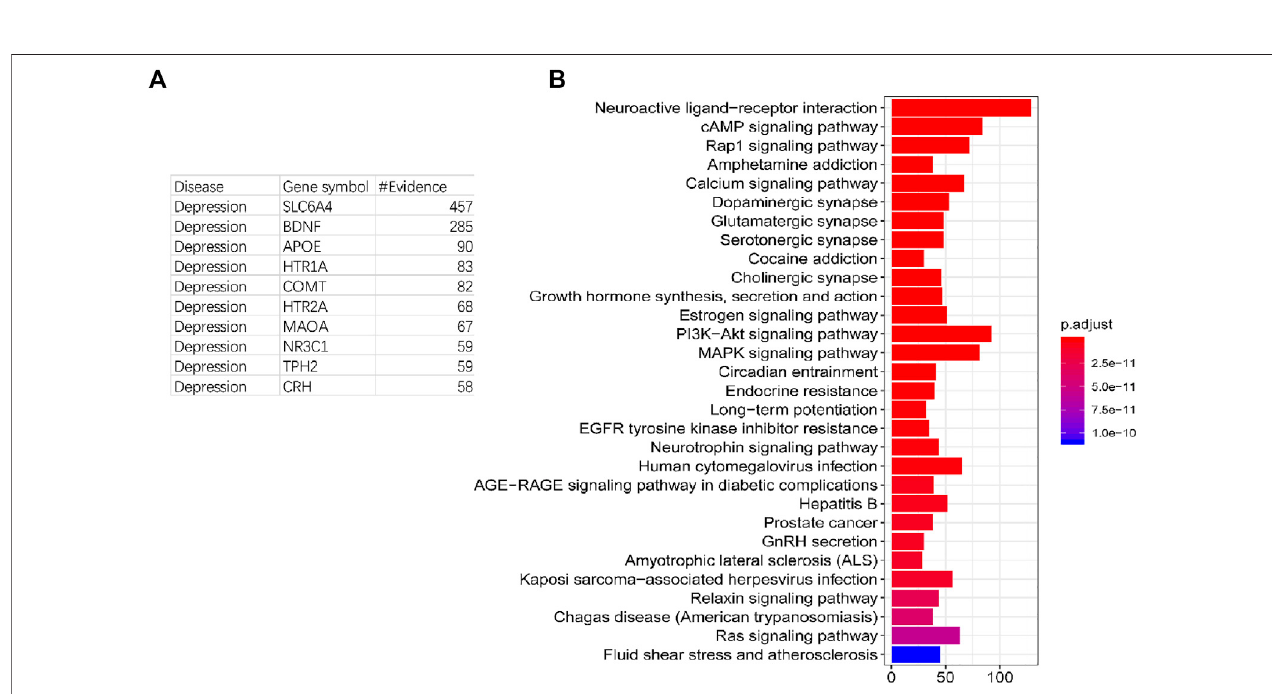
FIGURE2| Numberofevidenceandfunctionanalysisofpathogenicgenes. (A) :Thelistoftop10geneswiththehighestnumberofevidences. (B) :Top30enriched pathways of pathogenic genes.